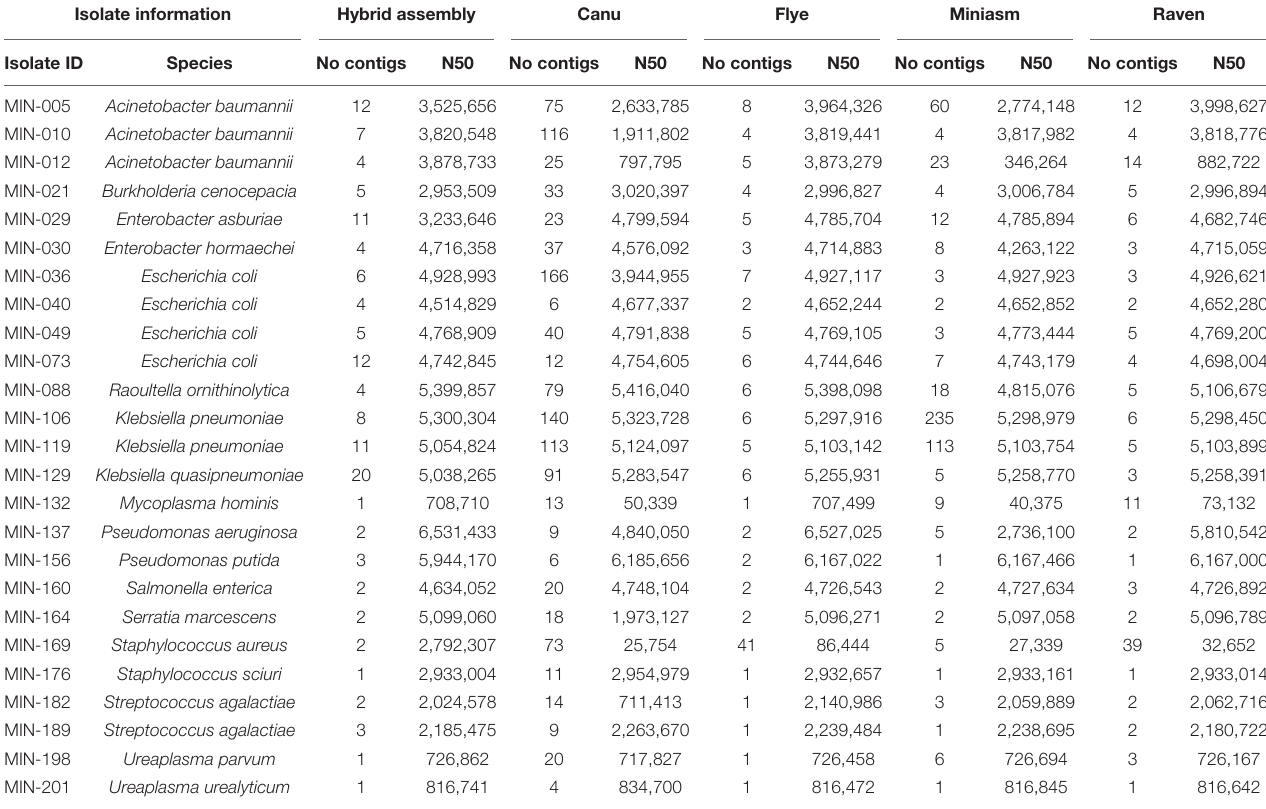
TABLE 3 | Comparison of Quast metrics number of contigs and N50 value between the hybrid assembly (internal reference) and the four assemblers used. Isolate information Hybrid assembly Canu Flye